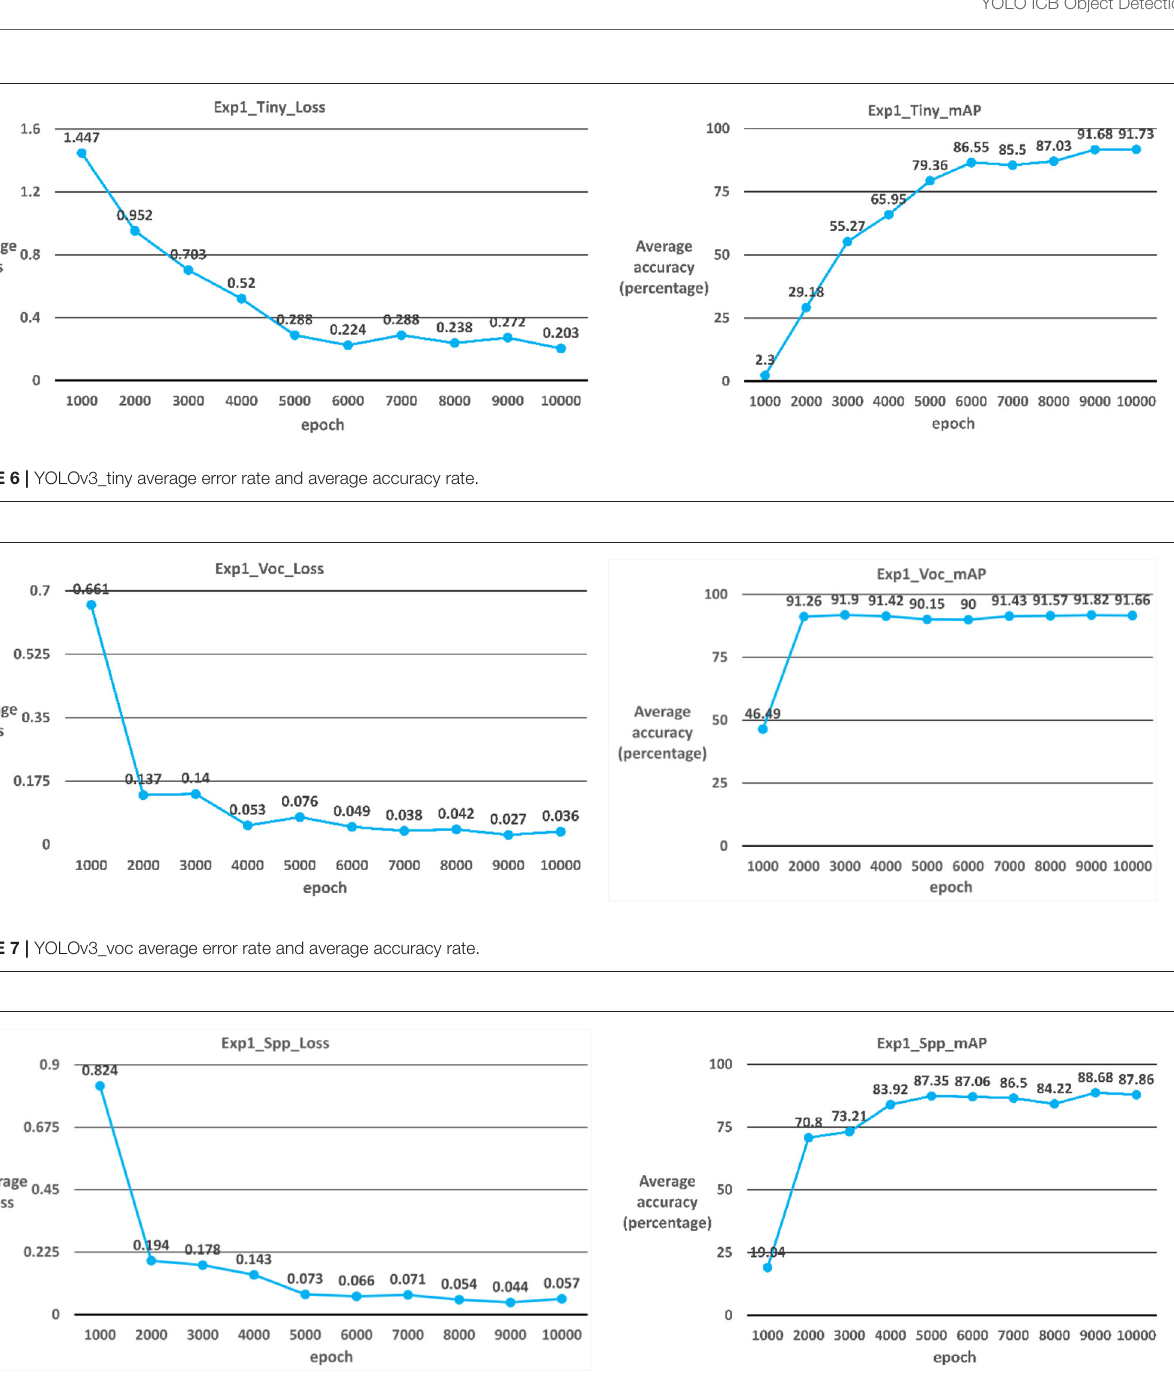
FIGURE 8 | YOLOv3_spp average error rate and average accuracy